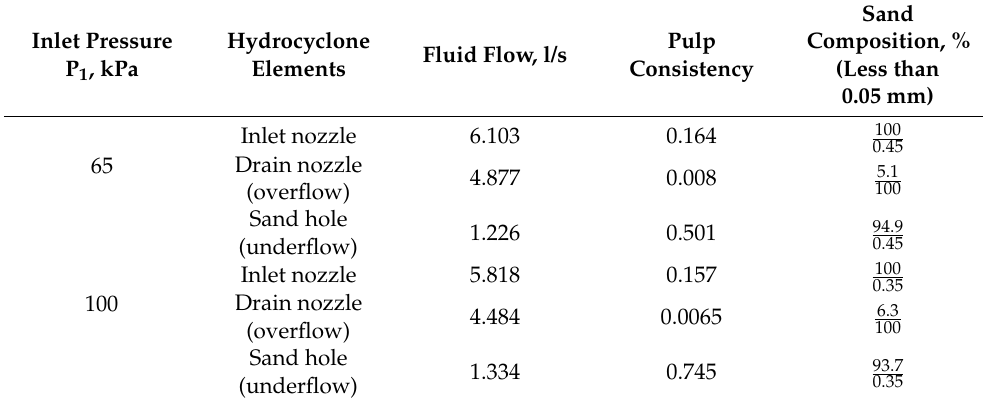
Sand Composition, % Pulp (Less than Consistency 0.05 mm)